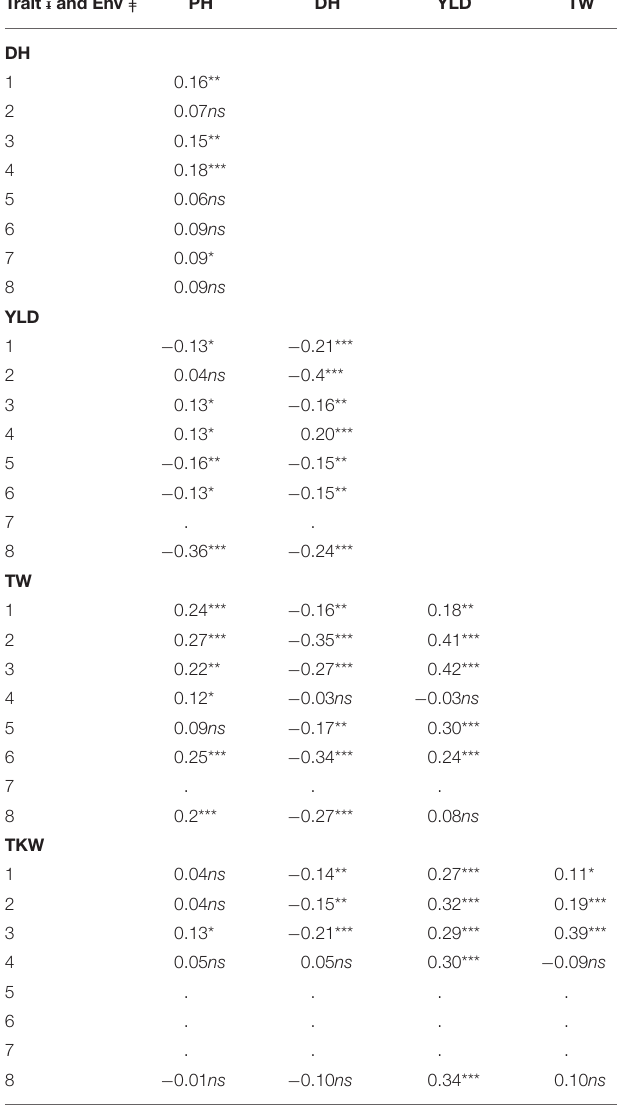
TABLE 2 | Correlation coefficients between five agronomic traits in the association mapping panel in different environments (Env.) and overall mean across environments